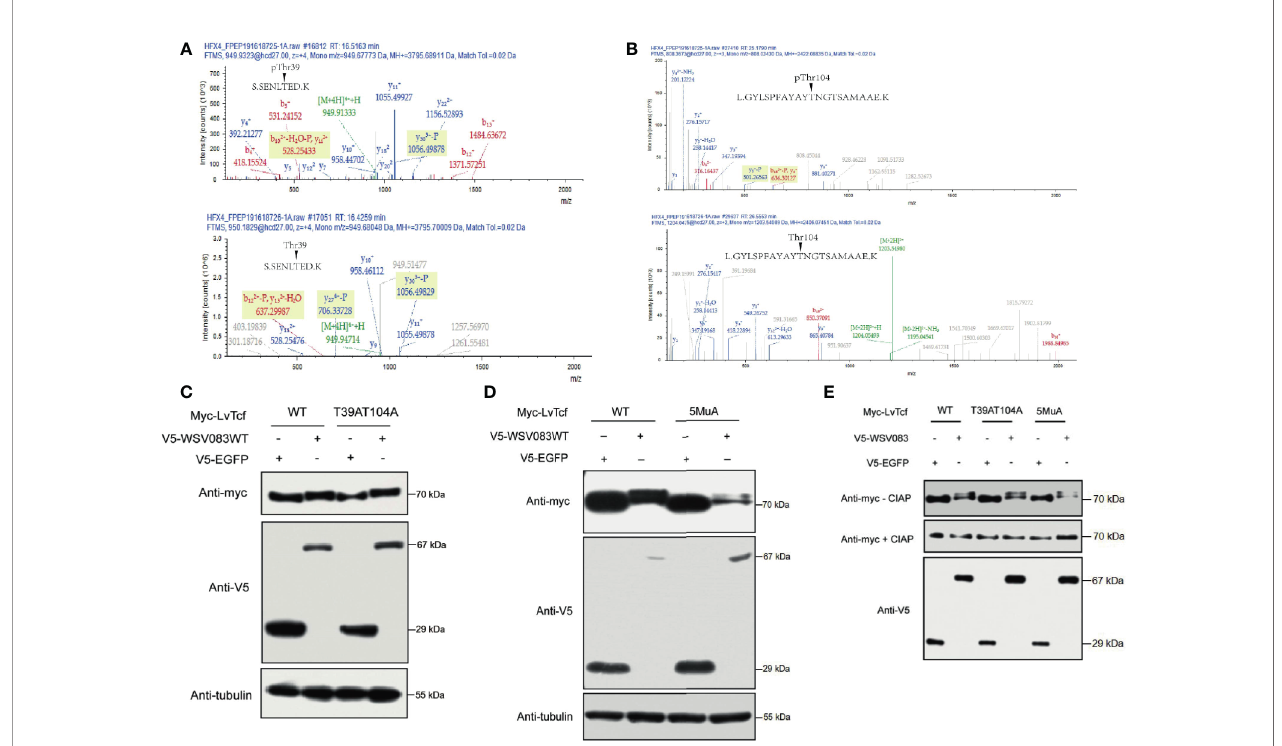
FIGURE 6 | Identi fi cation of WSV083 phosphorylation sites on LvTcf. (A, B) Mass spectrometry analysis of LvTcf immunoprecipitates revealed that Thr39 and Thr104 in LvTcf were phosphorylation sites targeted by WSV083. (A) or (B) upper panel: Spectrum analysis of LvTcf immunoprecipitated from cells co-expressing WSV083WT; lower panel: from cells co-expressing WSV083DM. (C, D) Myc-LvTcfT-39AT104A or Myc-LvTcf5MuA (T39A/T104A/T311A/S315A/S356A) still displayed their mobility shift when co-expressed with WSV083WT. Myc-LvTcfWT, Myc-LvTcfT39AT104A (C) , Myc-LvTcf5MuA (D) were co-expressed with V5-EGFP or V5-WSV083WT in High Five cells. After 36 h, cell lysates were subjected to western blotting, as indicated. (E) CIAP abolished the mobility shift of LvTcf mutants when co-expressed with WSV083WT. Myc-LvTcfWT, Myc-LvTcfT39AT104A, or Myc-LvTcf5MuA were co-expressed with V5-EGFP or V5-WSV083WT, respectively. At 36 h post-transfection, cell lysates were subjected to immunoprecipitation, CIAP treatment, and immunoblotting, as